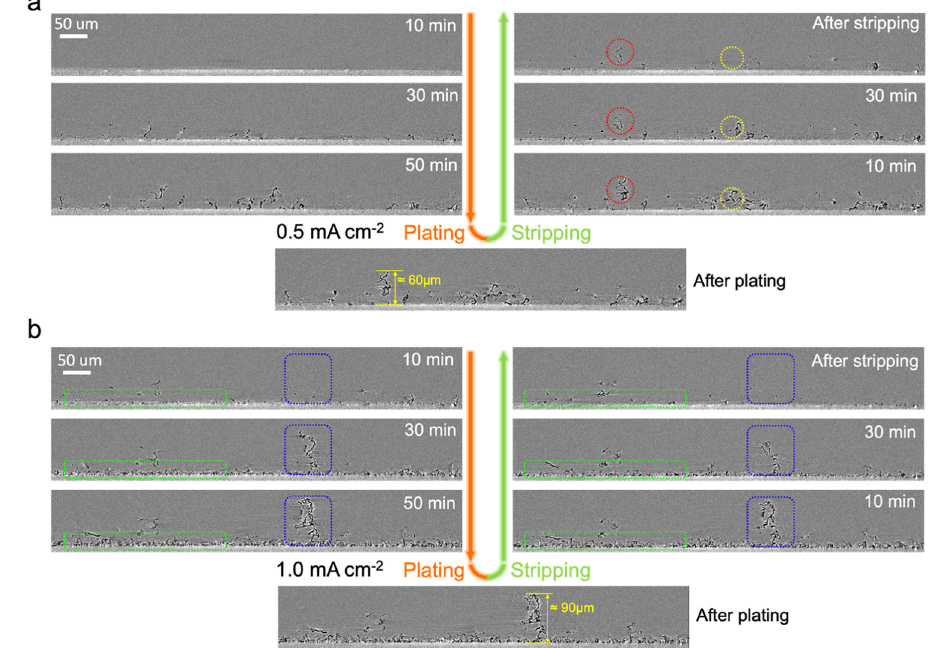
Fig. 3 | Operando XTM during plating and stripping at different current den- sities. a Reconstructed vertical slices during the fi rst cycle (0.5mAcm − 2 ). Struc- tures with dark color are metallic Li and gray background is the liquid electrolyte